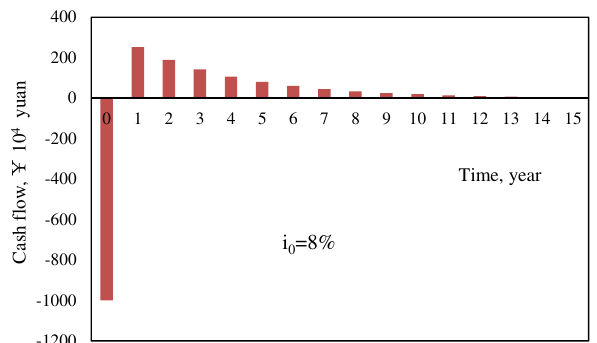
Fig. 3 Net cash flow chart with the internal rate of 8%